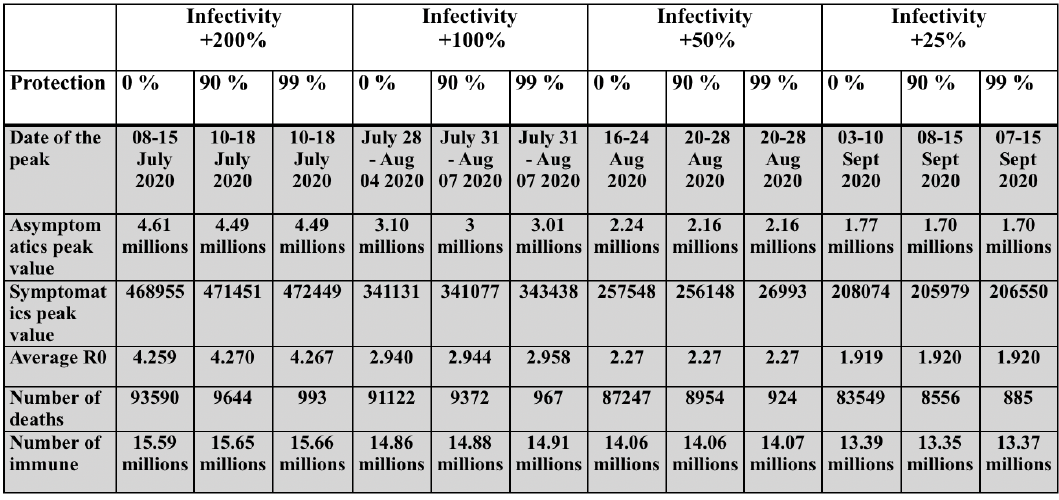
Table 2. COVID-19 Senegalese forecasts: collective